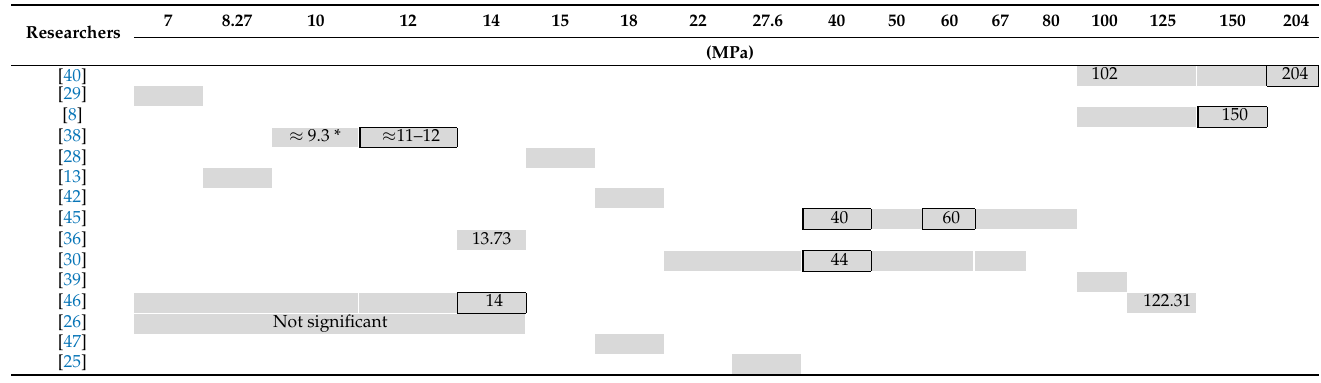
Table 8. Pressure levels applied during the briquetting